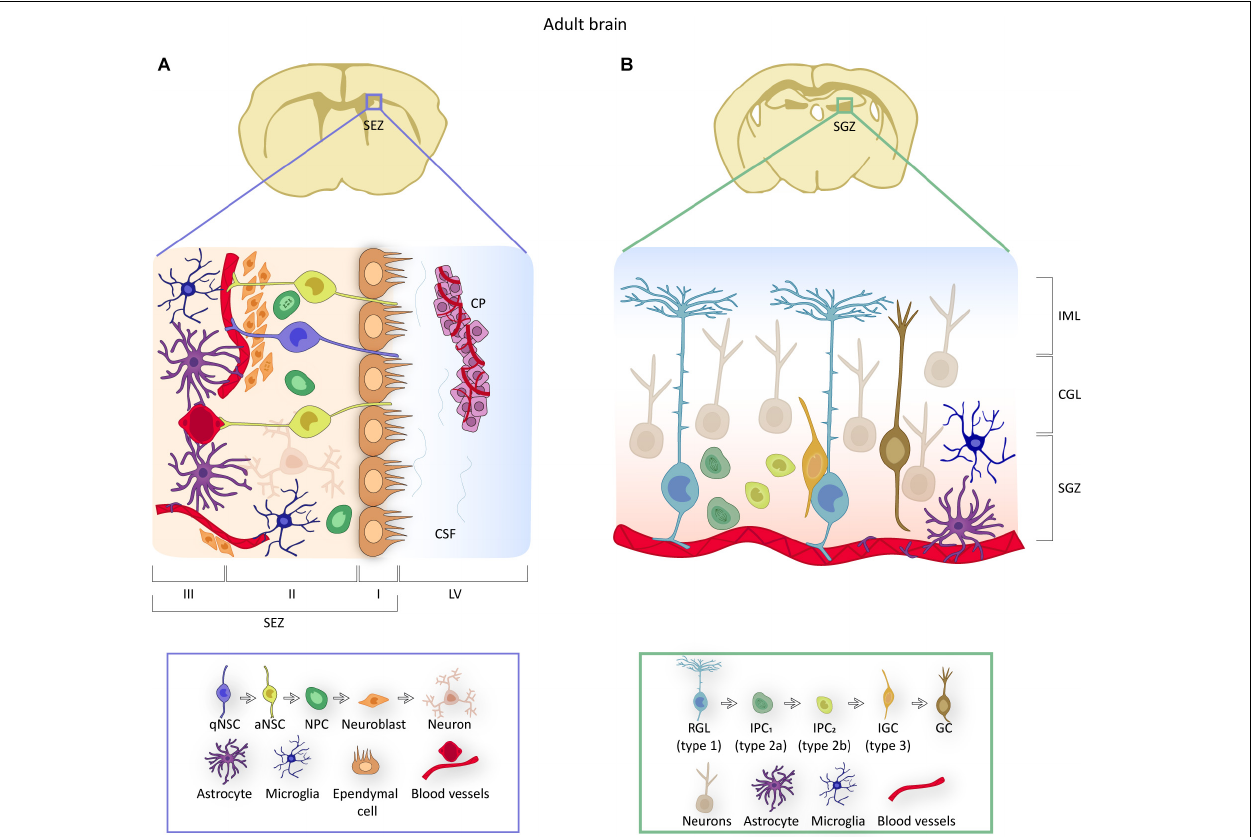
FIGURE 2 | NSCs in adult brain neurogenic niches. (A) Representation of the location and organization of the SEZ neurogenic niche. NSCs contact the ependymal cell layer apically and the blood vessels through a basal process. Due to their specific position, NSCs receive signals from the choroid plexus (CP) through their access to the CSF (domain I), from other cell components of the niche (domain II) and from the vasculature (domain III). The box below identifies the components of the niche and provides an overview of the NSC lineage within the SEZ, from quiescent (q) to activated (a) NSCs to neural progenitor cells (NPCs) to neuroblasts. (B) Illustration of the location and organization of the hippocampal neurogenic niche. In the SGZ, NSCs or RGLs contact blood vessels and give rise to intermediate progenitor cells (IPCs) that progress into type 3 neuroblasts or intermediate granule cells (IGCs), to finally differentiate into granule cells (GC) that are located in the granule cell layer (GLC) and the inner molecular layer (IML). Mature granule cells constitute the neuronal circuitry of the DG. The box below includes an overview of the RGL lineage.